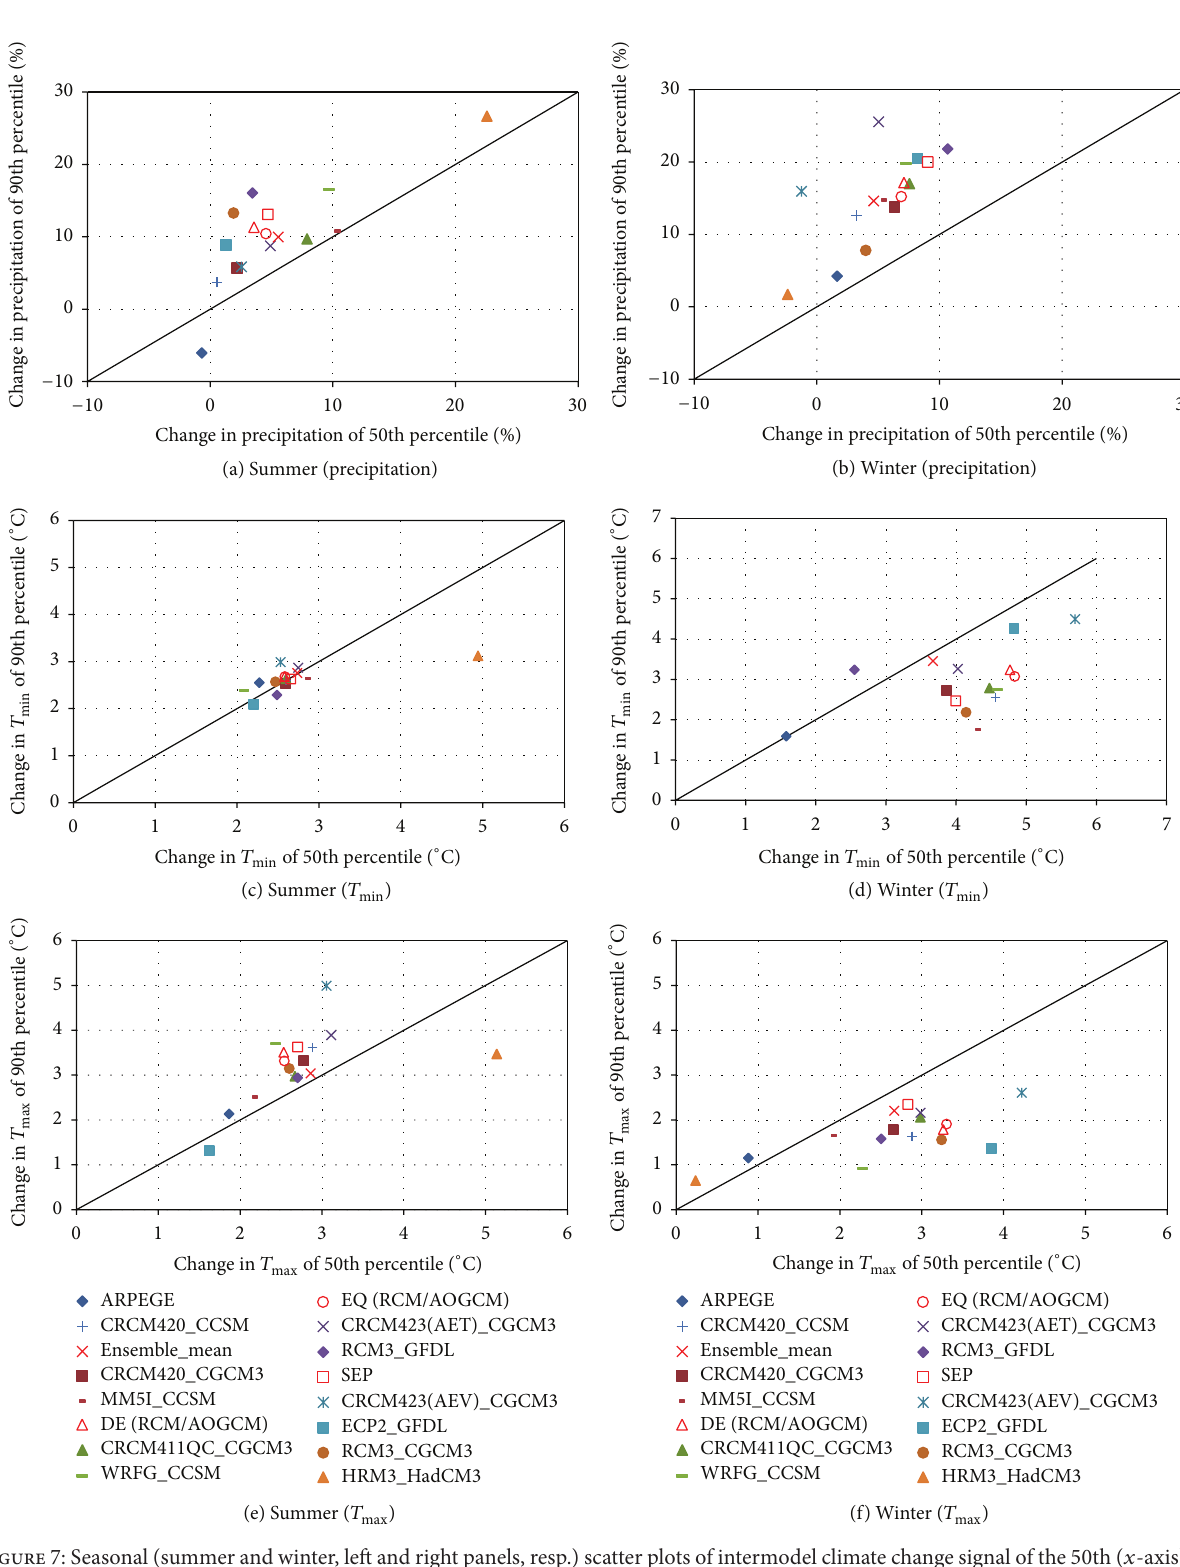
Figure 7: Seasonal (summer and winter, left and right panels, resp.) scatter plots of intermodel climate change signal of the 50th ( 𝑥 -axis) and 90th ( 𝑦 -axis) percentile values for precipitation ((a) and (b) panels) and minimum ((c) and (d) panels) and maximum ((e) and (f) panels) temperatures: all values are spatially averaged over the study